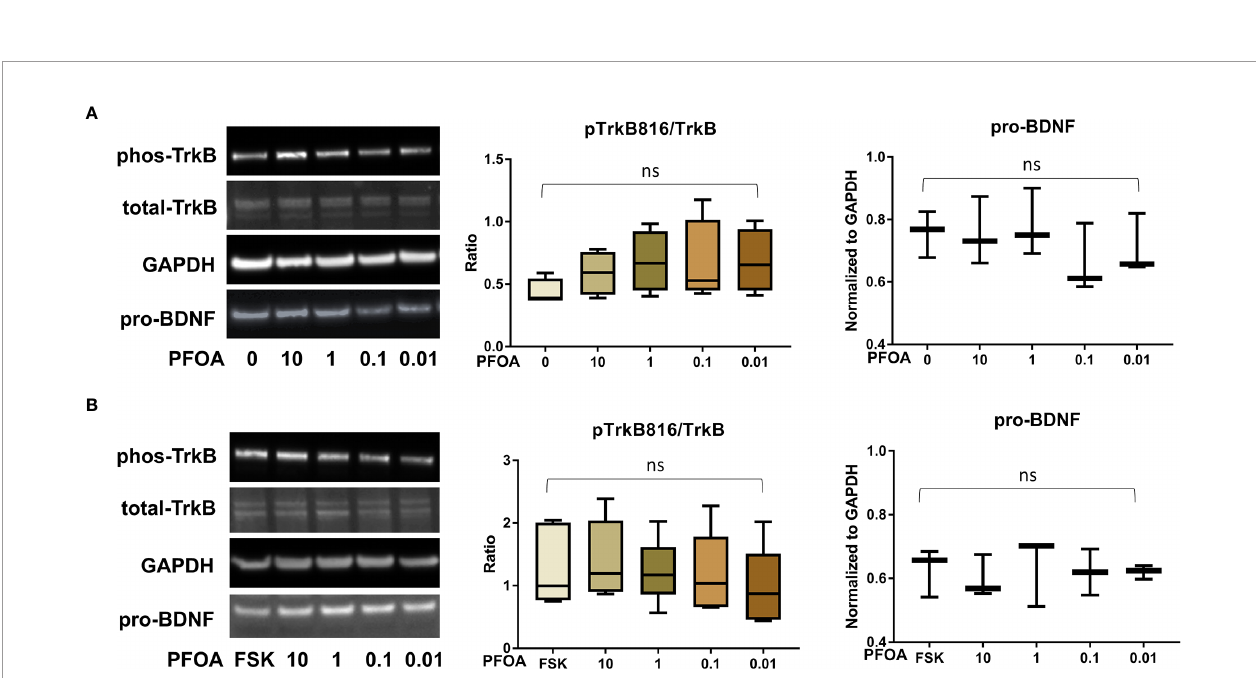
FIGURE 6 | PFOA exposure did not signi fi cantly disrupt the BDNF-TrkB pathway. (A) Representative Western blot images of phos-TrkB, total-TrkB, GAPDH, and pro-BDNF in BeWo cells without forskolin (FSK) treatment exposed to PFOA (0, 0.01, 0.1, 1, and 10 µM) and box plots for densitometry analysis; (B) Representative Western blot images of phos-TrkB, total-TrkB, GAPDH, and pro-BDNF in BeWo cells with FSK treatment exposed to PFOA (0, 0.01, 0.1, 1, and 10 µM) and box plots for densitometry analysis. ns indicates differences in protein levels were not signi fi cant. pTrkB816 represents for phosphorylation of TrkB at Tyr816